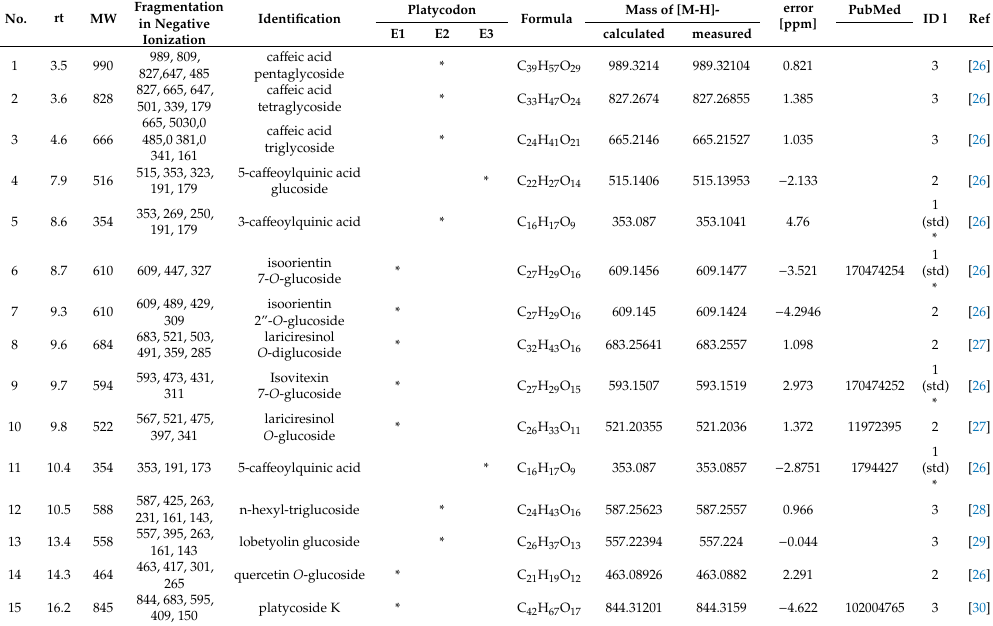
Figure 3. UV chromatogram of the E3 extract from Platycodon grandiflorum A. DC recorded at λ = 230 nm ( A ) and λ = 280 nm ( B ) by UPLC system. Chromatographic profiles of metabolites were obtained with gradients of two solvents: A (water acidified with 0.1% formic acid) and B (100% acetonitrile), mobile phase flow of 0.4 mL/min on a RP C18 column at 40 °C. The gradient elution: 100% of A linearly changed to 80% of A over 2 min, then to 70% of A over 8 min and to 5% of A over 1 min. The number corresponded to numbers of identified metabolites in Table 2. Table 2. Secondary metabolites identified in Platycodon grandiflorum A. DC extracts by LC-MS systems.